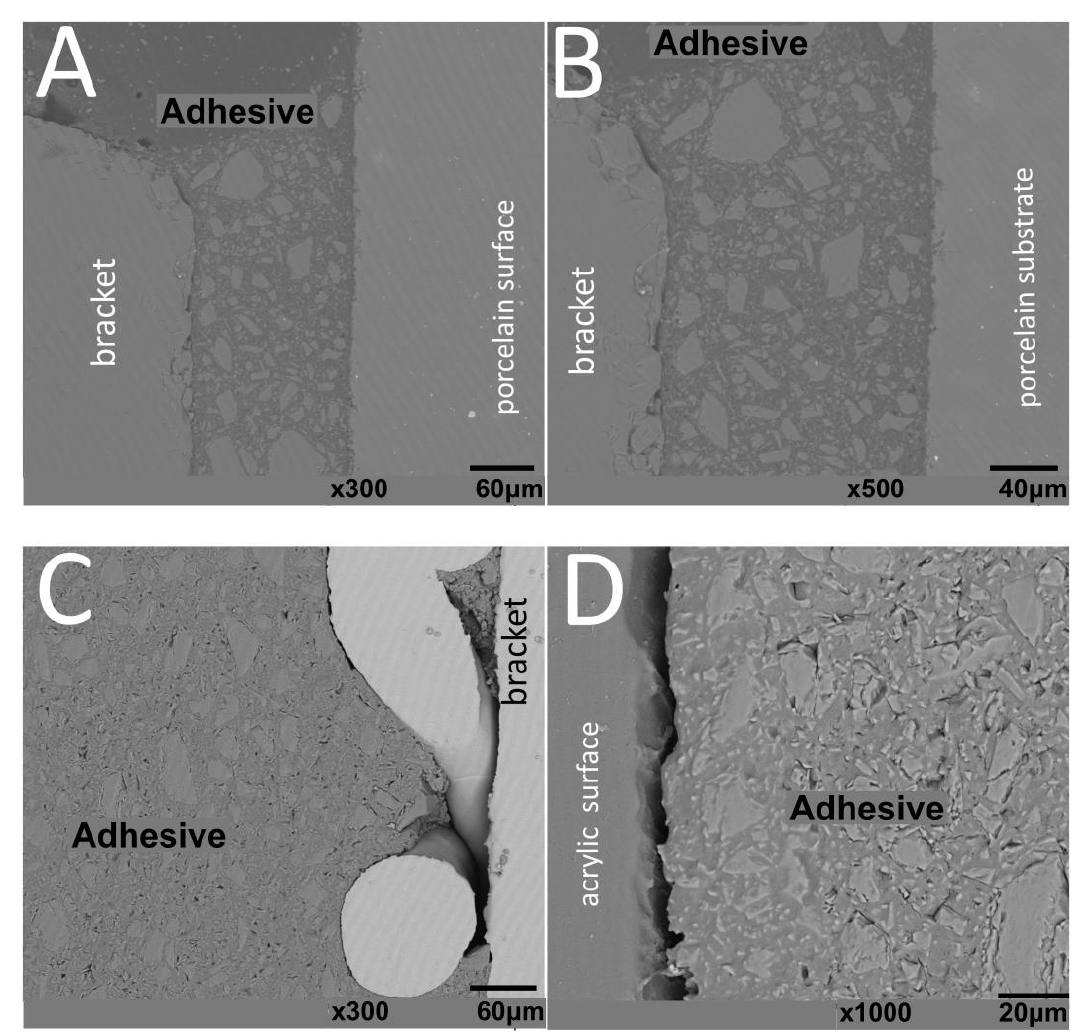
Figure 5. SEM images of ceramic brackets bonded to ( A , B ) glass–ceramic or ( C , D ) acrylic surfaces after thermal cycling.